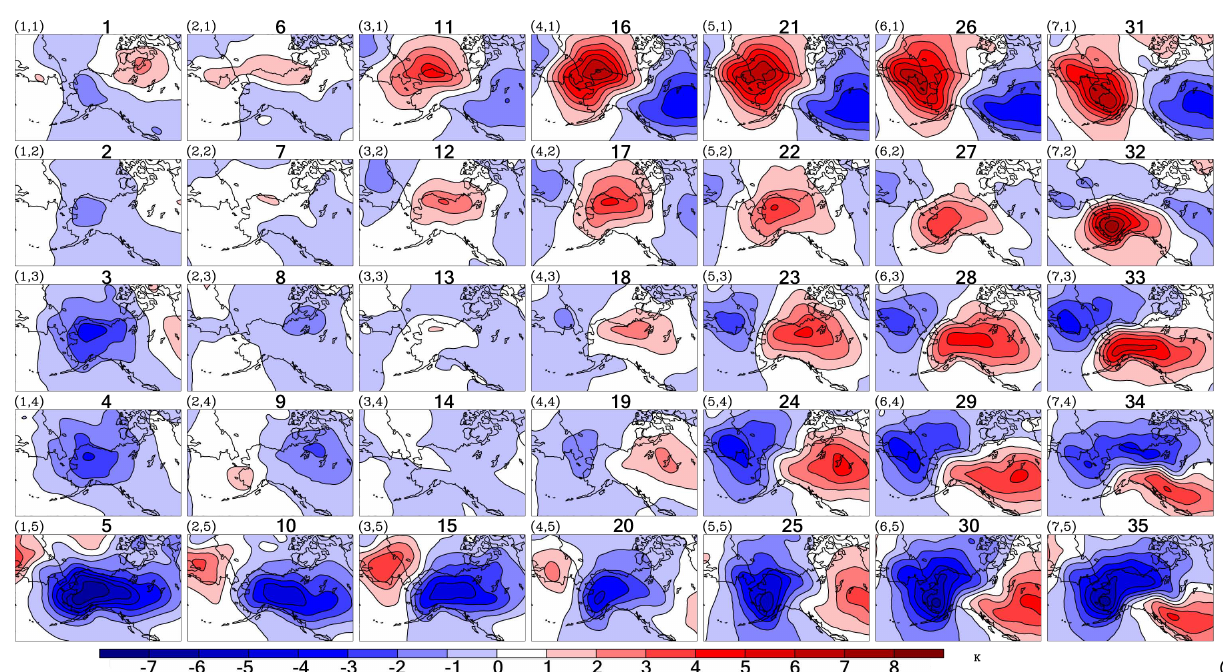
Fig. 3. (a) Pattern-averaged temperature anomaly for each SOM node at the lake. For example, over the study period, on any day that pattern 26 was dominating, one could expect a 4.9 ◦ C warmer air temperature than the mean for that day of the year. Thus, if the frequency of pattern 26 increased over time, one would expect the mean annual air temperature to rise too. (b) Temperature anomalies for each SOM node across the entire domain. These plots aggregate the analysis of (a) (at Lake El’gygytgyn) for each grid point in the domain. The plots should aid substantially in understanding teleconnections between the lake and the surrounding domain. For example, pattern 26 that brings such anomalously warm air to the lake also brings cold air to Canada, whereas pattern 5 brings cold air nearly everywhere. Figure 1 and (b) are referred to constantly throughout the text, so having them close at hand or printed out separately is advised by the authors, as there is a lot of information packed into